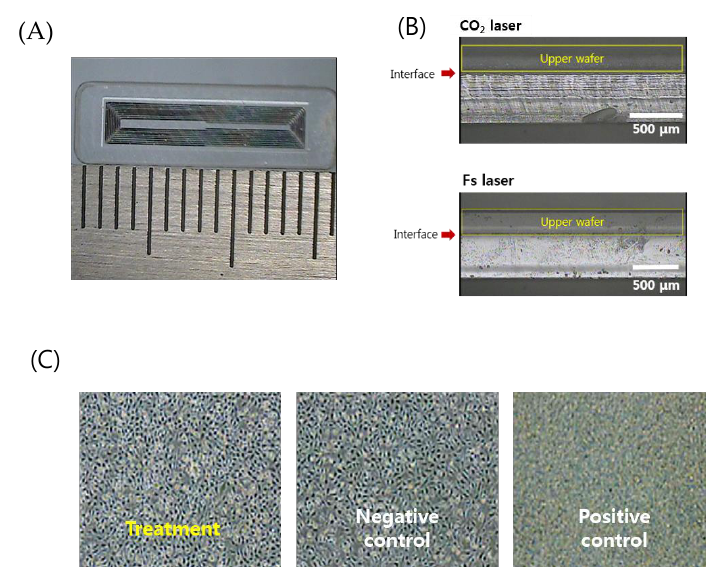
Figure 7. ( A ) An optical image of the separated sensor using the laser cutting (4 mm × 16 mm × 0.75 mm). ( B ) Comparison of the laser-cut cross sections by the CO 2 laser cutting and femtosecond laser